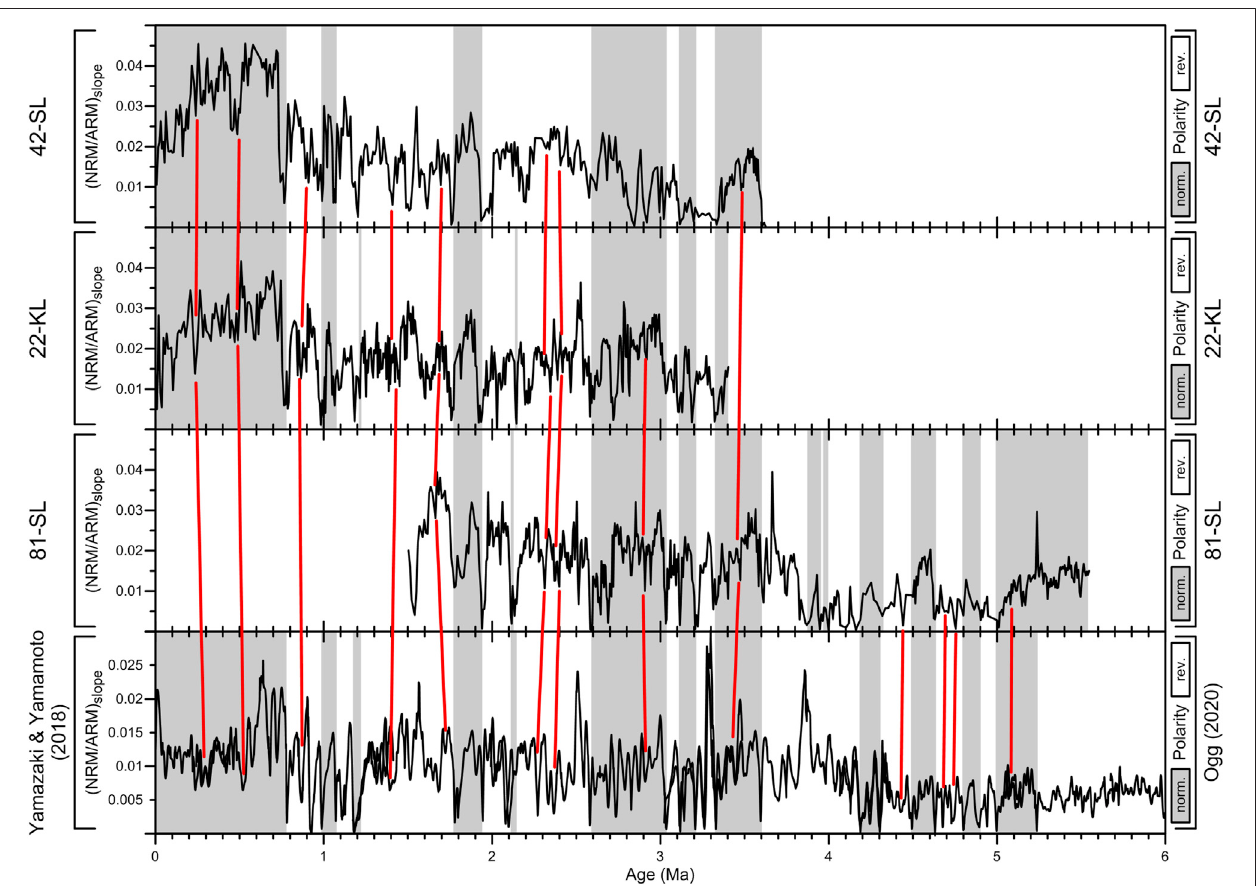
FIGURE 6 | RPI records and reversal patterns (in grey) of cores 42-SL, 22-KL and 81-SL in comparison to RPI reference data by Yamazaki and Yamamoto (2018) and GTS2020 reversal ages from Ogg (2020). Red tie lines mark additional chronostratigraphic anchor points inside longer polarity zones. The individual records agree well for the recovered sections in the fi rst ∼ 3.6 Ma. No convincing signal correlations were found in the 3.3 – 4.4 Ma interval of core 81-SL due to unusually low signal amplitudes and considerable dissimilarity from the reference RPI record.